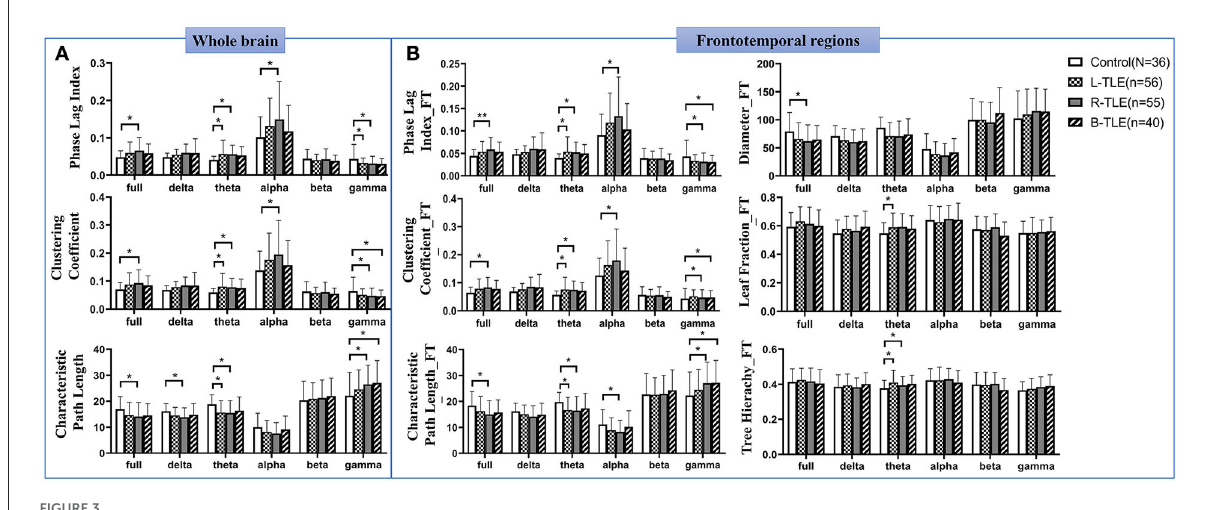
FIGURE3 Alterations of the whole and frontotemporal network in patients with TLE. Differences of the classical weighted network in the whole brain among patients with TLE and the controls (A) . Alterations of the frontotemporal network in patients with TLE (B) . * P < 0.05; ** P < 0.01.